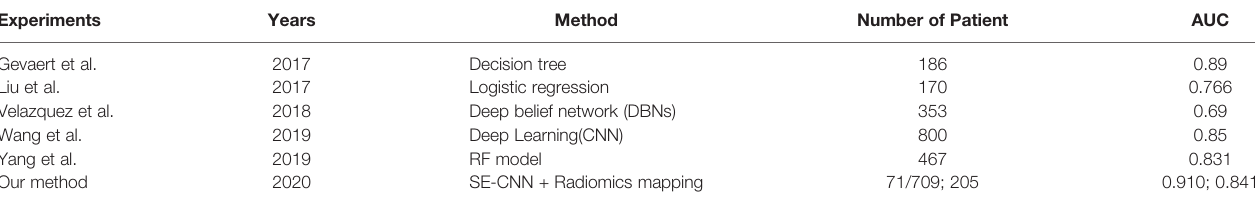
AUC, Area Under Curve; RF, Random Forest; SE, Squeeze-and-Excitation layer; CNN, Convolutional Neural